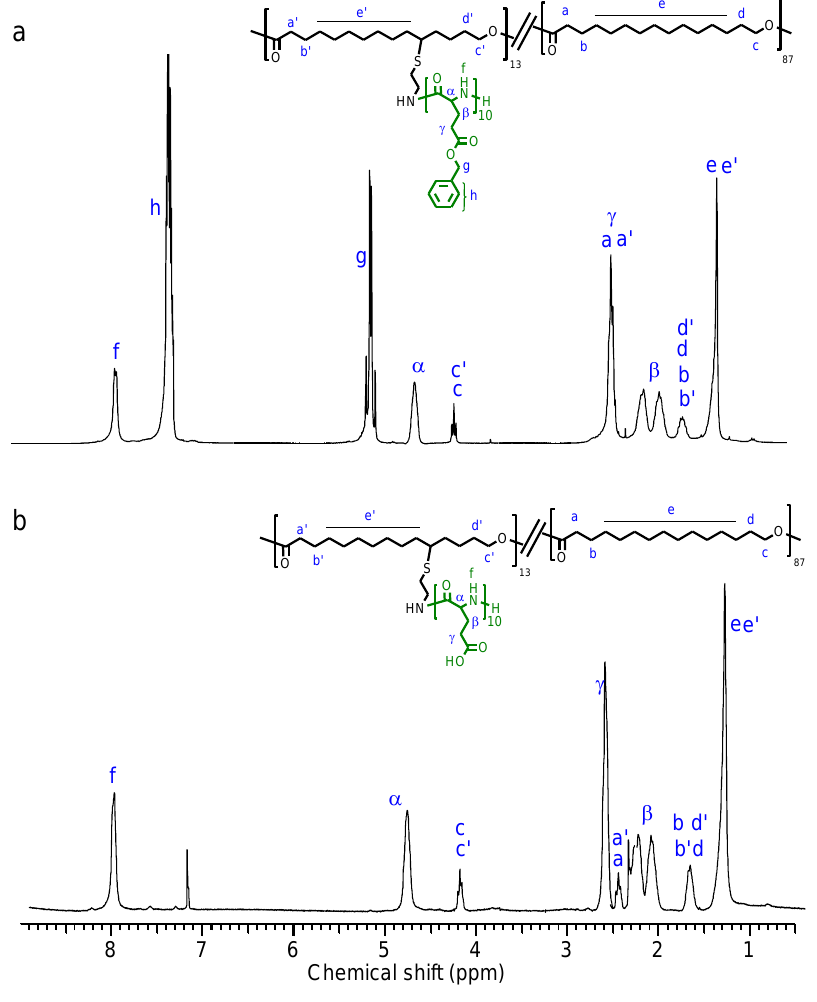
Figure 3. 1 H NMR (CDCl 3 / trifluoroacetic acid (TFA)) spectra of ( a ) P[(Gl 13 - r -PDL 87 )– g –(BLG) 10 ] and ( b ) P[(Gl 13 - r -PDL 87 )– g –(LGA) 10 ] copolymers. Table 4. Thermal properties of P[(Gl x - r -PDL y )– g –(LGlu) z ] copolymers.